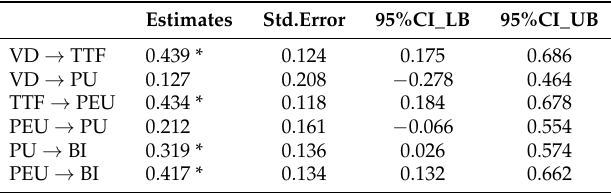
Table 6. Estimates of path